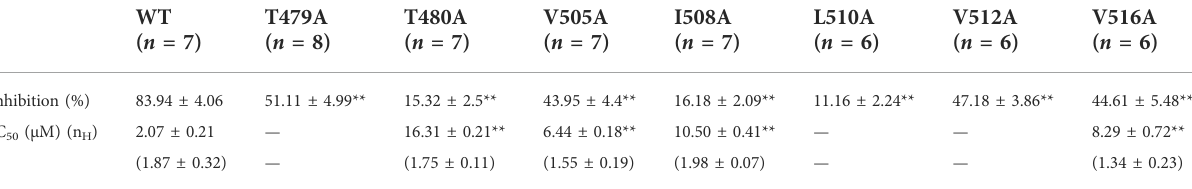
TABLE 1 Inhibition of HMQ1611 on mutant hKv1.5